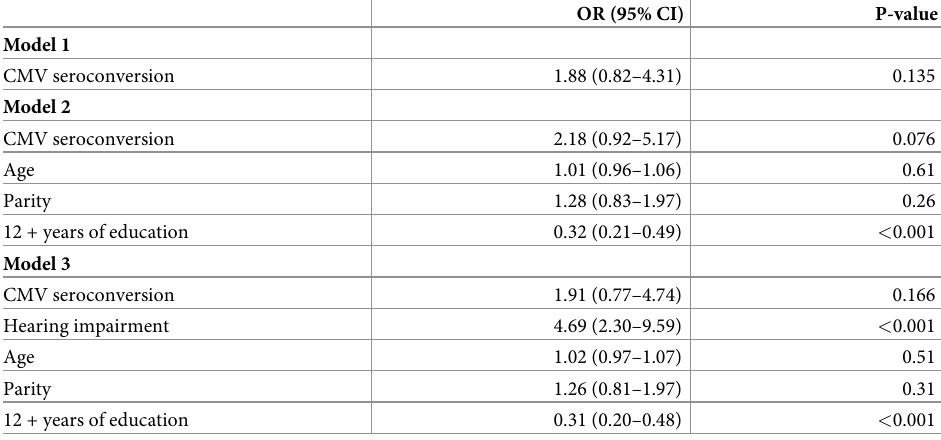
Table 6. Results from logistic regression modelling, with crude and adjusted odds ratios for the association between CMV IgG seroconversion and delayed language